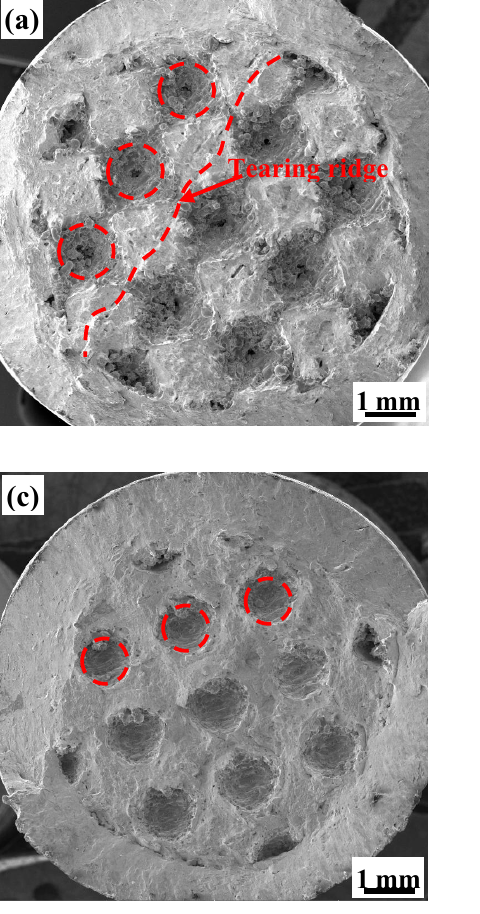
Figure 11. Scanning electron microscopy (SEM) images of: ( a ) the complete fracture morphology of 7P (dotted line depicts a tearing ridge); ( b ) the local fracture micromorphology at high-magnification of 7P; ( c ) the complete fracture morphology of 8P; and ( d ) the local fracture micromorphology at high-magnification of 8P.